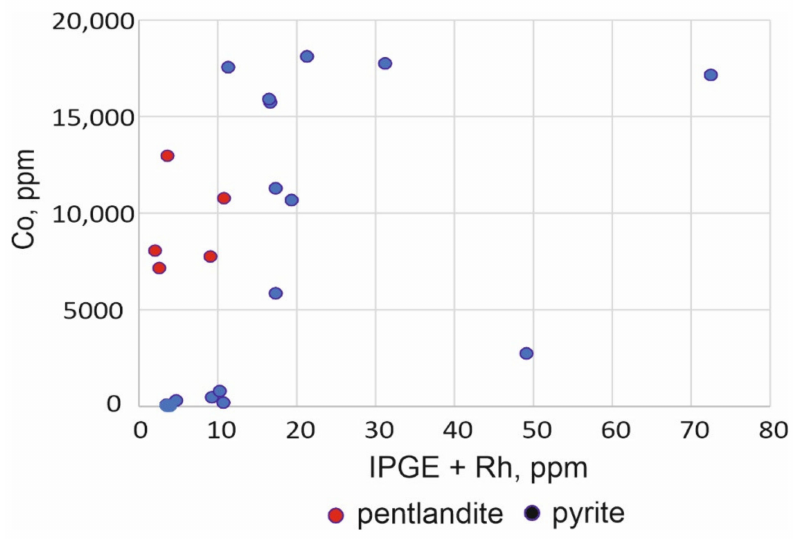
Figure 13. A total sum of IPGE + Rh versus Co contents (ppm) in pentlandite and pyrite, LA-ICP-MS data. The graph shows a positive correlation for both types of